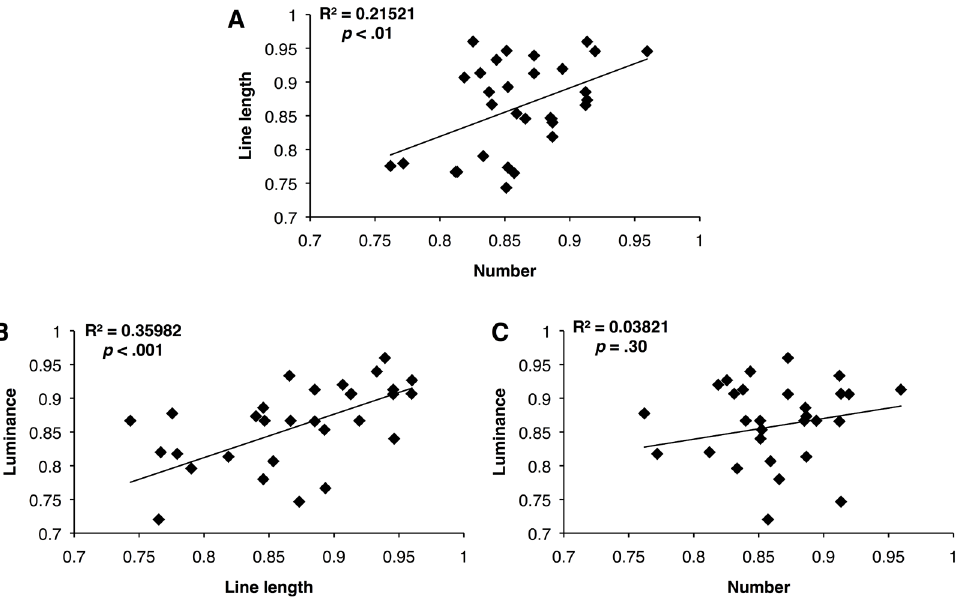
Figure 4. Correlational analyses illustrating the relation between adults’ performance in the different magnitude comparison tasks. Number and line length (A) and line length and luminance (B) are significantly correlated whereas number and luminance (C) do not exhibit a significant